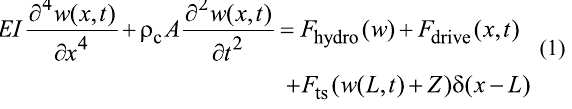
namic force, tip–sample interaction force, driving (excitation force), and Dirac delta, respectively. The hydrodynamic